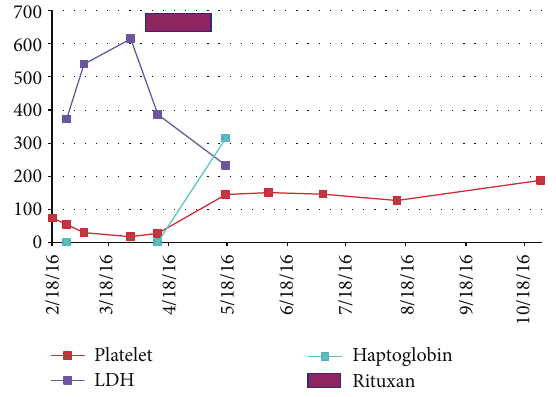
Figure 2: Platelet count, LDH, and haptoglobin response with rit- uximab